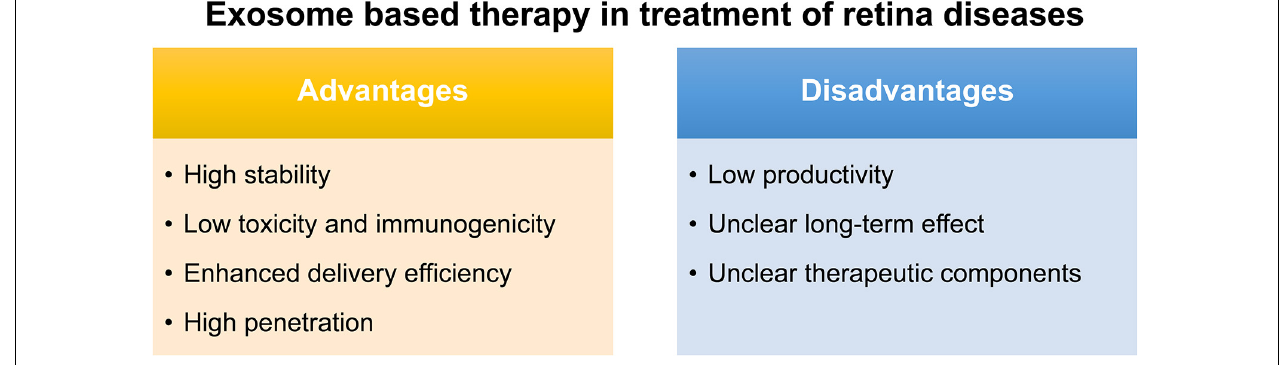
Frontiers in Cell and Developmental Biology |